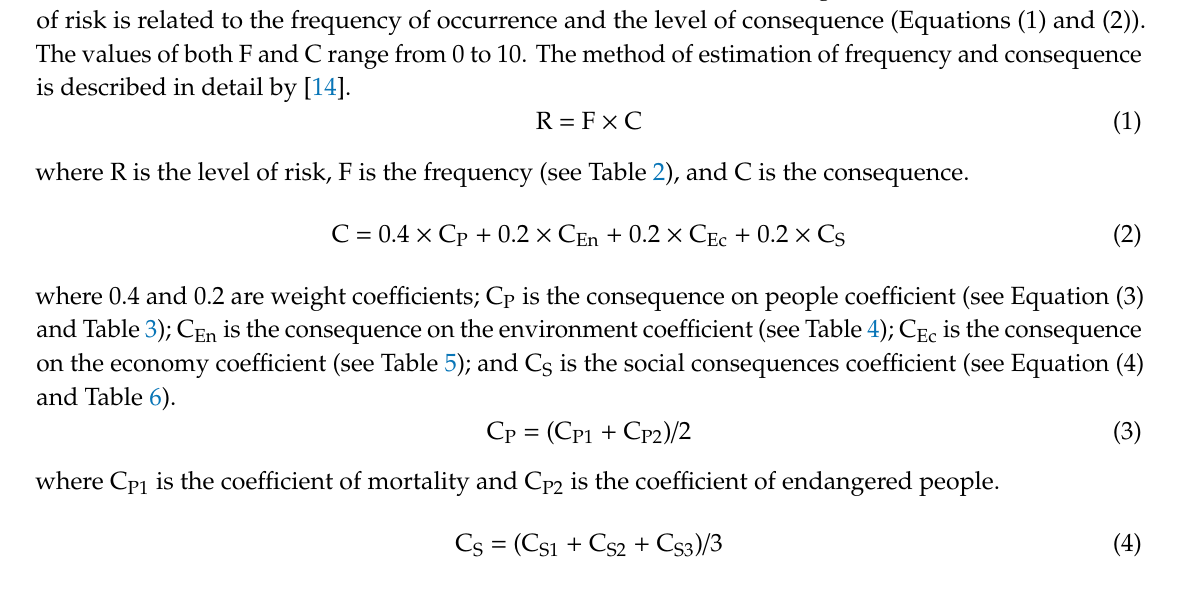
Figure 7. Spatial expression of combined risk.